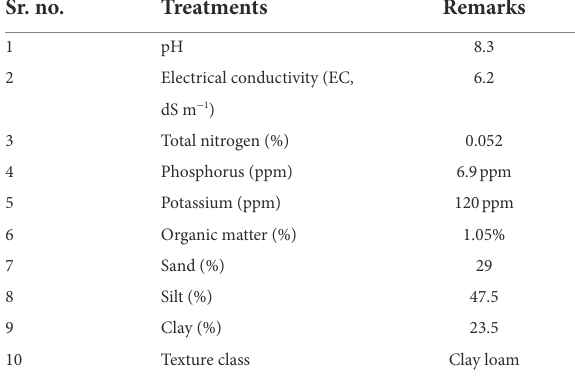
TABLE 1 Physio-chemical properties of soil used in MB biodegradation microcosm studies. Sr.